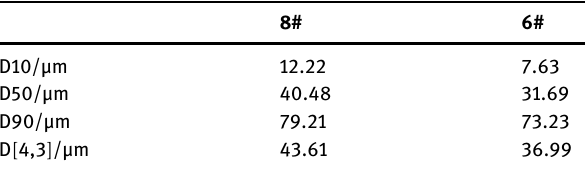
Table 5: Particle size characteristic values of 6# and 8# samples